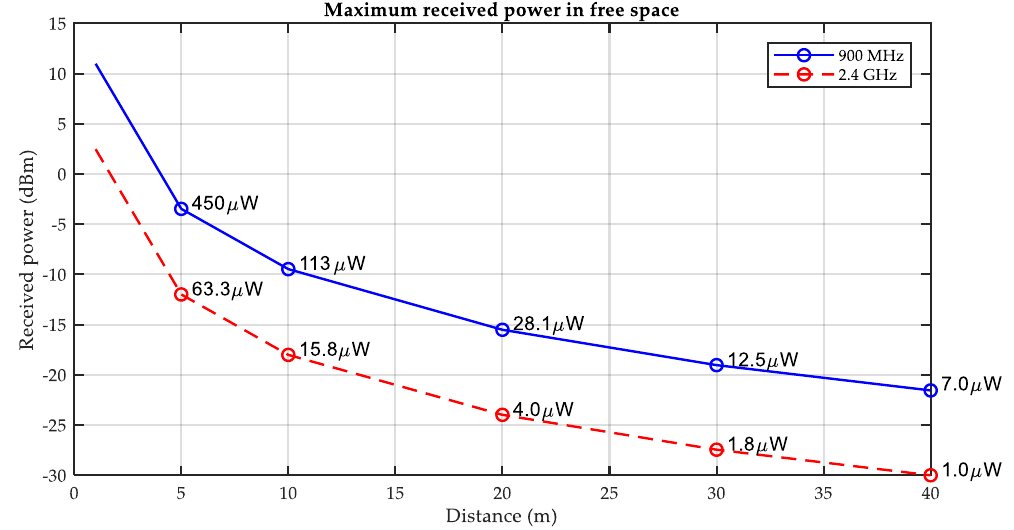
Figure 8. Relationship between received power and distance for RF energy harvesting.